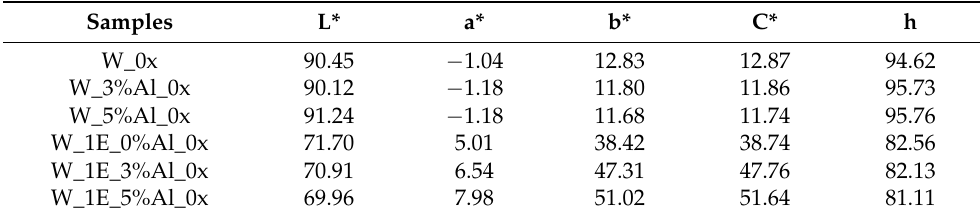
Table 4. Color coordinates of wool samples dyed with SJL aqueous extract with and without mordants before washing.